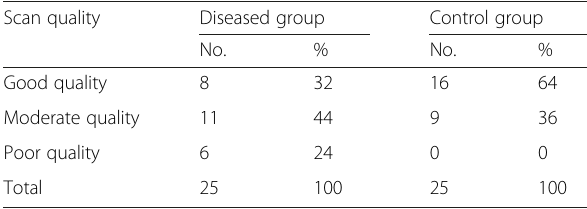
Table 1 Image quality analysis of T-SLIP non-contrast MR